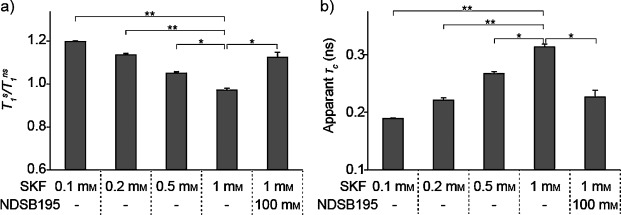
T1s/T1ns and apparent τc values of SKF under various conditions. a) The T1s/T1ns value of the H1 proton of SKF and b) the apparent τc under various conditions. *: P<0.001, **: P<0.0001.